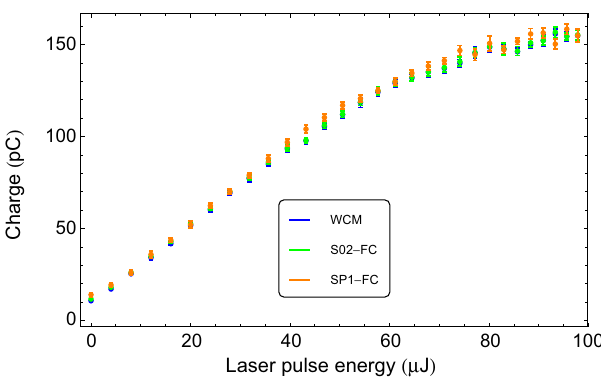
FIG. 26. Cross-calibration measurement of the bunch charge between the CLARAWCM, the straight-on FC (S02-FC), and the VELA spectrometer FC (SP1-FC) as a function of the photo- injector laser